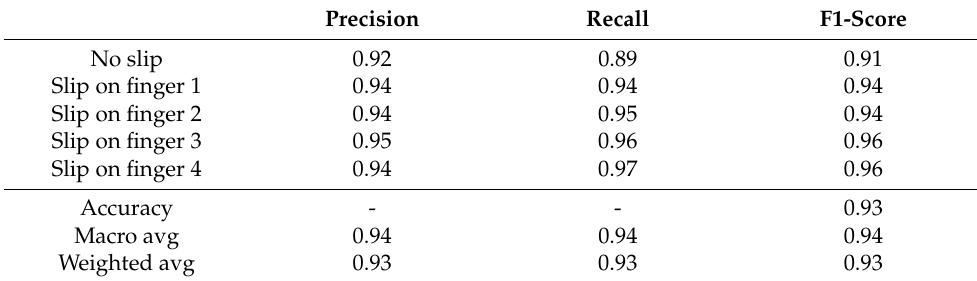
Table 1. F1-score of the proposed LSTM algorithm.